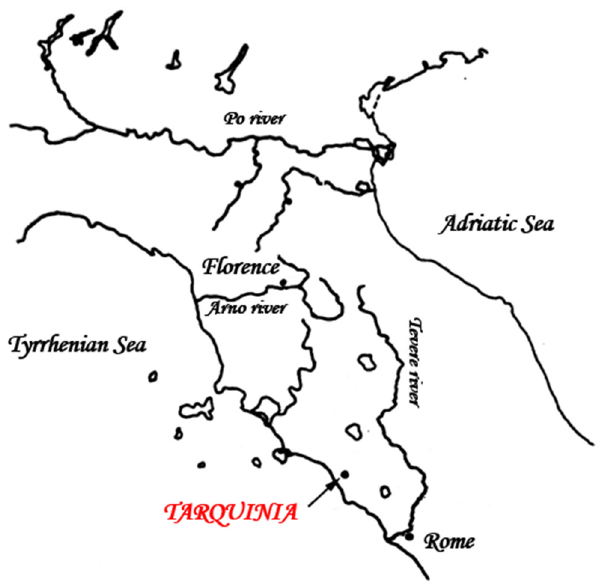
Figure 1. Localization of Tarquinia in the map of Central